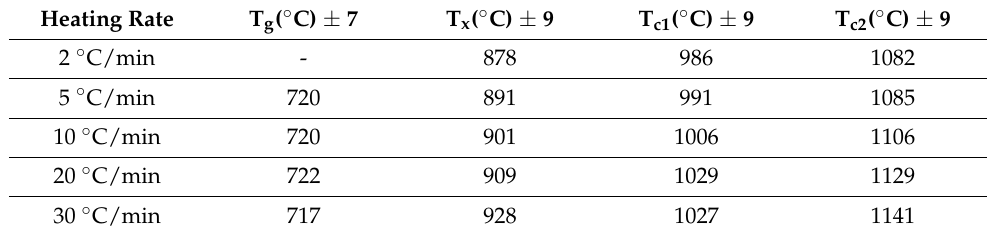
Table 2. T g , T x , and T c of the undoped glass (ø < 20 µ m) determined by DTA.